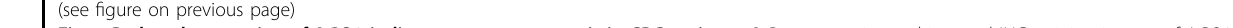
Fig. 1 Reduced expression of AGO2 indicates a poor prognosis in CRC patients. A Representative multispectral IHC staining images of AGO2 protein. The scale bars are 100 μ m. B Comparison of the levels of AGO2 in CRC cancer tissues and normal tissues. C The protein level of AGO2 analysed in primary colon tumor tissues and normal tissues from the CPTAC data. Z -values represent standard deviations from the median across samples for the given cancer type. D Multispectral IHC staining images for AGO2, E-cadherin, vimentin, and DAPI in cancer tissues. The scale bars are 100 μ m. E , F Pearson correlation analysis between the H-scores of AGO2 and E-cadherin ( E ) and AGO2 and vimentin ( F ). G , H Kaplan – Meier plots for the OS ( G ) and DFS ( H ) of 284 CRC patients who underwent curative resections. Data are expressed as the mean ± SD. * p < 0.05, ** p < 0.01, and **** p < 0.0001.